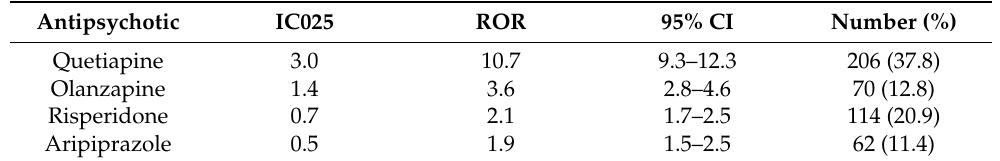
Table 8. Disproportionality analysis for main antipsychotics involved in reports of intentional misuse in patients aged between 12 years and 17 years, ranked by ROR.